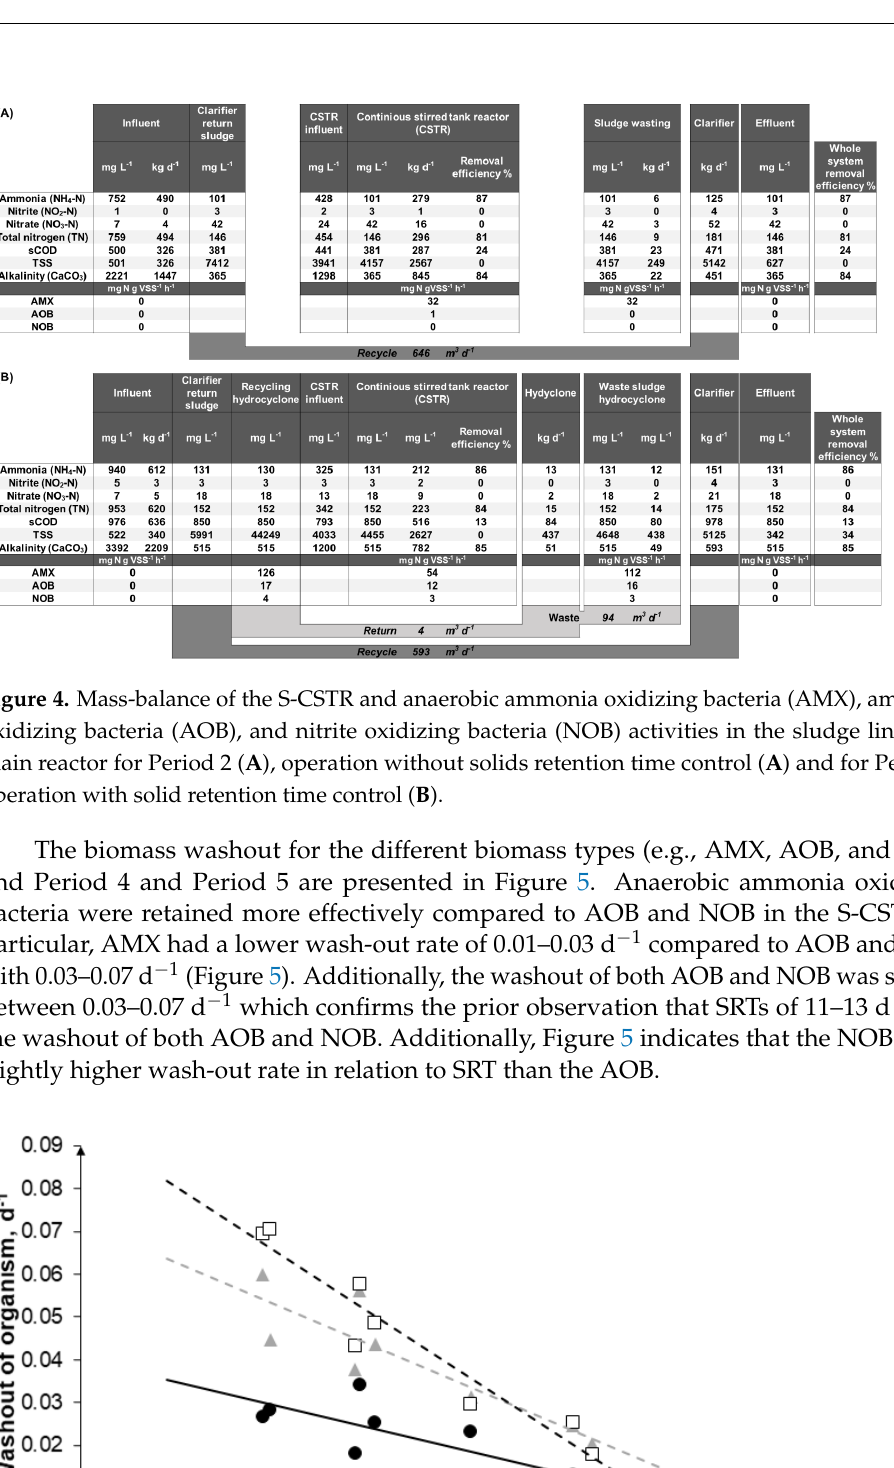
Figure 6. The relative abundance of main genus types for AMX ( Candidatus Scalindua ), denitrification ( Denitratisoma ), par- tial nitritation ( Nitrosomas ), and nitratation ( Nitrospira ) for hydrocyclone overflow underflow as well as a reactor for Period 1 to Period 5.